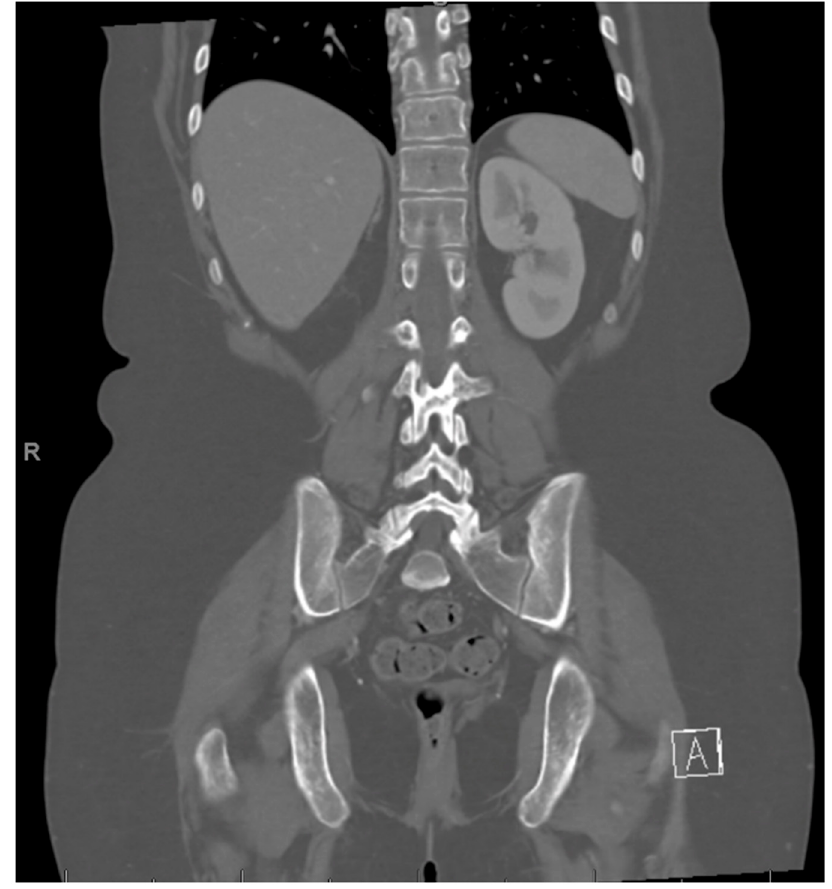
Figure 6. Post right nephrectomy.